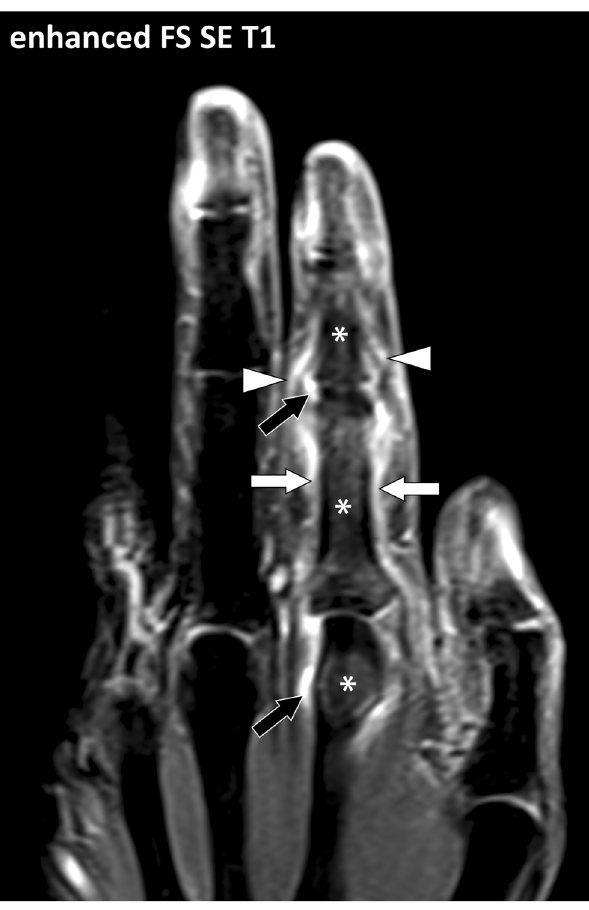
Fig. 20 Contrast-enhanced fat-suppressed T1-weighted coronal image of the hand of a 35-year-old male with psoriatic arthritis and dactylitis of the second digit. MRI demonstrates periostitis of the proximal phalangeal bone with thickening and enhancement of the periosteum (white arrows) and osteitis (asterisks). These changes are associated with synovitis of the metacarpophalangeal and proximal interphalangeal joints (black arrows). The connective tissue located at the interfaces between tendons, joint capsules and bone is also involved (arrowheads)